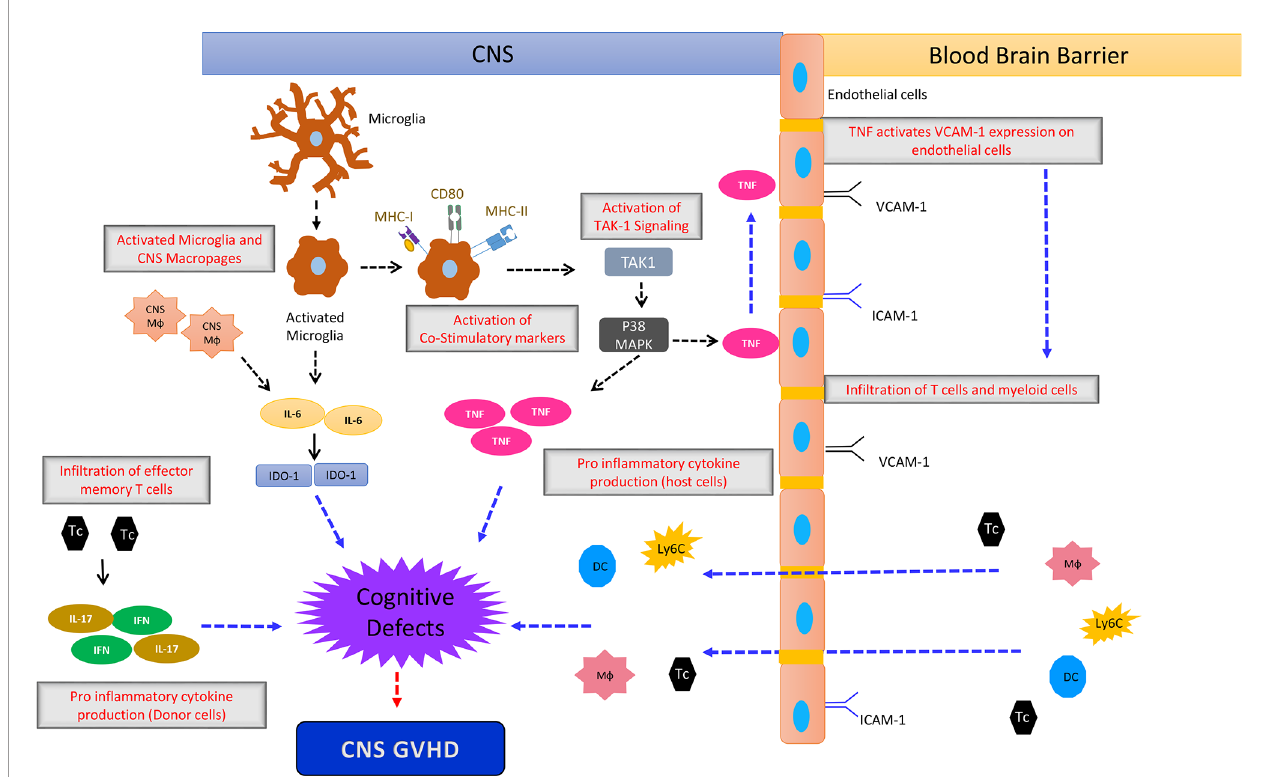
FIGURE 2 | The simpli fi ed sketch shows the proposed mechanism how CNS-GVHD evolves and contributes to neuronal damage ultimately leading to cognitive de fi cits. An initial event is the activation of microglia by stimuli that are not well characterized so far, being most likely damage associated molecular patterns (DAMPs) and pathogen associated molecular patterns (PAMPs). Activated microglia upregulates MHC I and II as well as CD80 leading to increased T cell priming. Additionally microglia- and macrophage-derived IL-6 impacting IDO-1 induces neurological defects, leading to the clinical picture of CNS GVHD. TNF derived from microglia has direct neurological toxicity. Donor T cells polarized towards Th1 and Th17 contribute to CNS GVHD as well as macrophages, monocytes and DC from the periphery. M ф , Macrophage; DC, Dendritic Cells; Tc, T cells; Ly6c + cells,